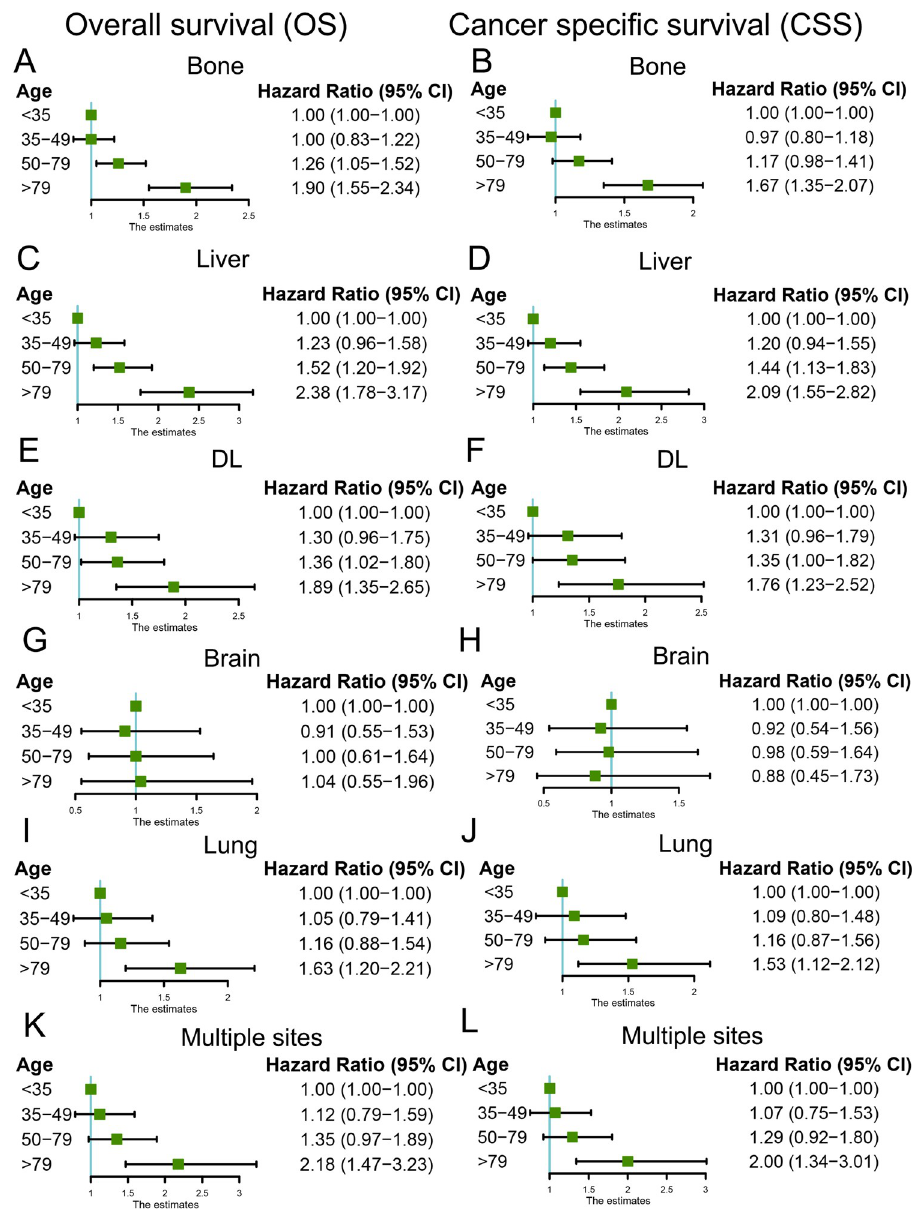
Fig 6. Multivariate Cox regression analyses for OS and CSS in MBC patients with different metastasis sites. ( A ) OS in patients with bone metastasis; ( B ) CSS in patients with bone metastasis; ( C ) OS in patients with liver metastasis; ( D ) CSS in patients with Liver metastasis; ( E ) OS in patients with DL metastasis; ( F ) CSS in patients with DL metastasis; ( G ) OS in patients with brain metastasis; ( H ) CSS in patients with brain metastasis; ( I ) OS in patients with lung metastasis; ( J ) CSS in patients with lung metastasis; ( K ) OS in patients with multiple sites metastasis; ( L ) CSS in patients with multiple sites metastasis. OS, overall survival; CSS, Cancer-specific survival; DL, Distant Lymph node.